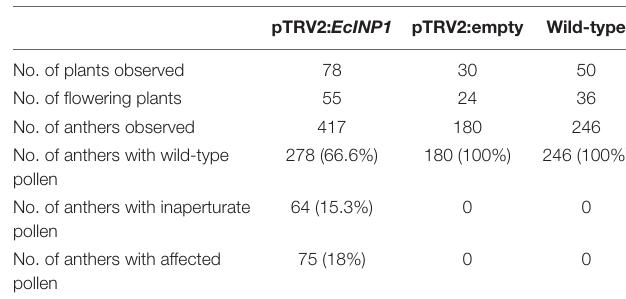
TABLE 1 | Summary of VIGS experiments to silence the EcINP1 gene of Eschscholzia californica